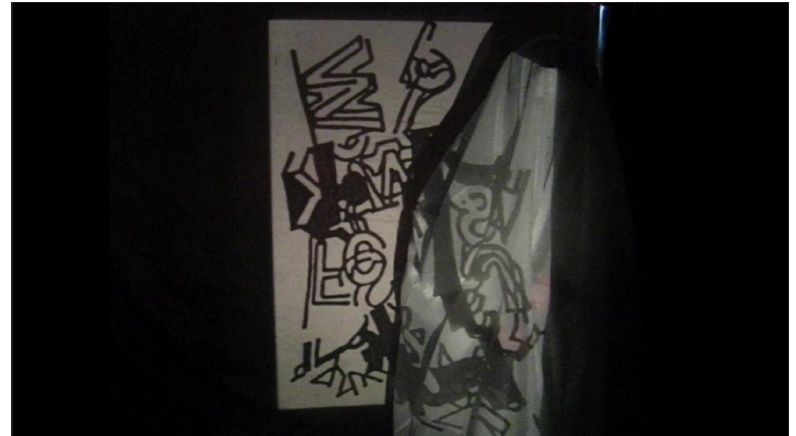
Figure 4.3: (06.24) Jennifer Pike with Veryan Weston, 2007. Courtesy of Veryan Weston.